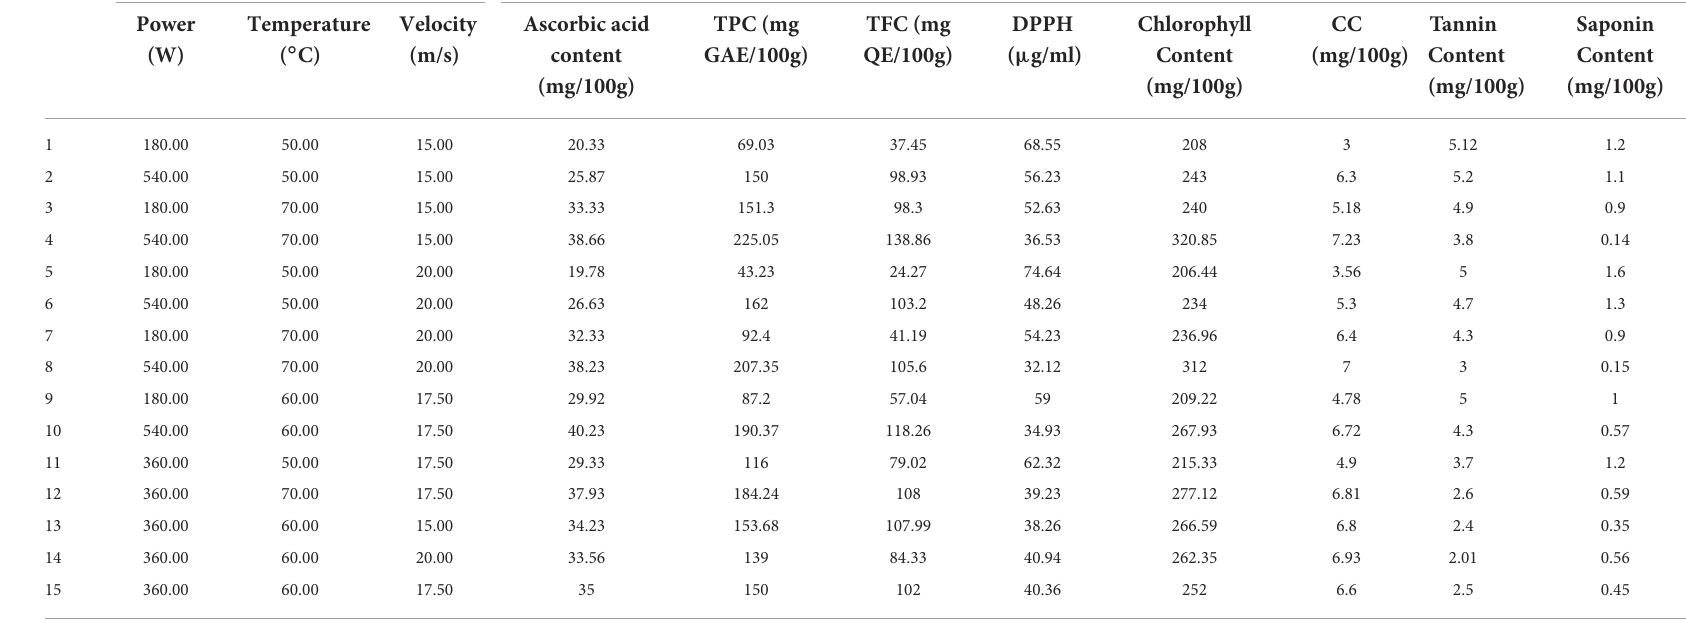
TABLE 2 Experimental results of investigated responses obtained under different drying